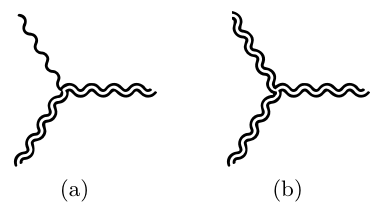
Figure 1 . V V V vertices with massive